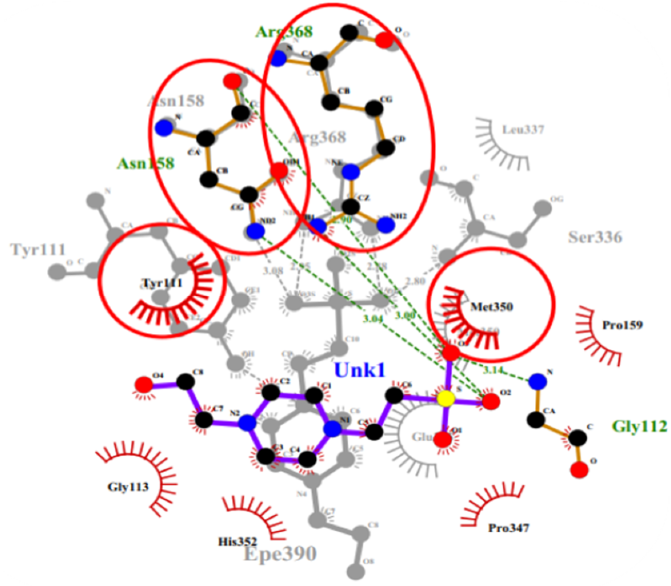
Figure 6. LigPlot+ of superimposition between the co-crystallized ligand of 3QHX and the re-docked HEPES ligand. Red circles represent the superimposed molecular interactions between both the co-crystallized and the re-docked